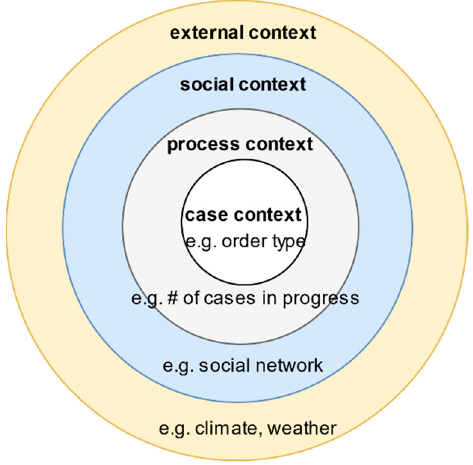
Figure 1. Contextual Factors and Relationship—(Adapted from [1]).